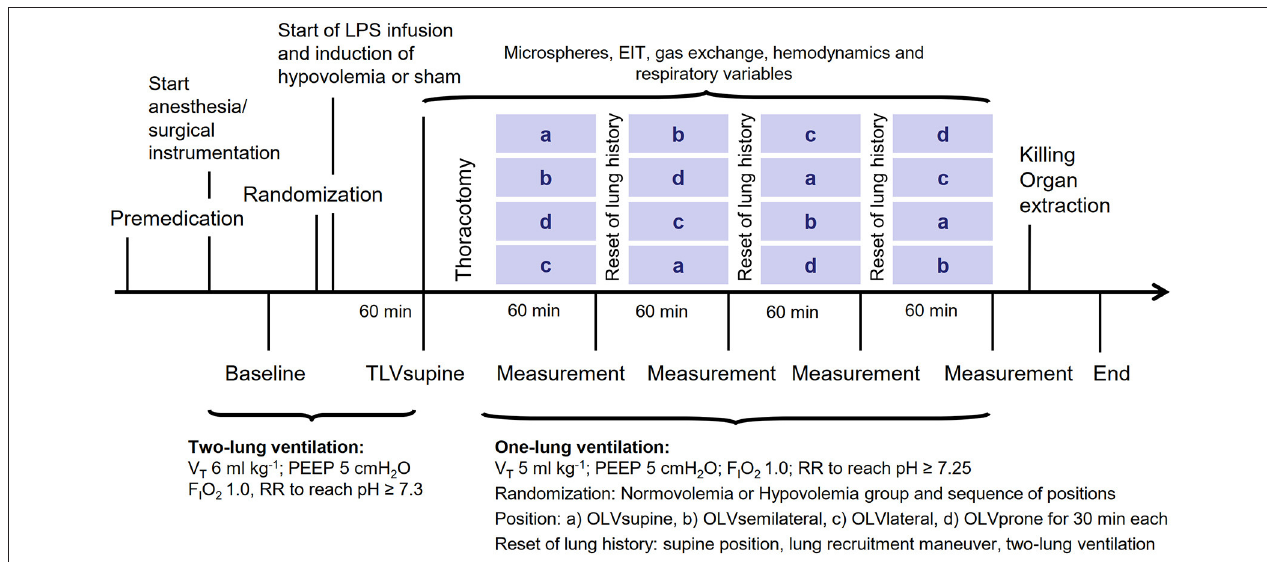
FIGURE 1 | The time course of the interventions and measurements. LPS, lipopolysaccharide; V T , tidal volume; PEEP, positive end-expiratory pressure; F I O 2 , fraction of inspired oxygen; RR, respiratory rate; microspheres, measurement of regional pulmonary perfusion; EIT, electrical impedance